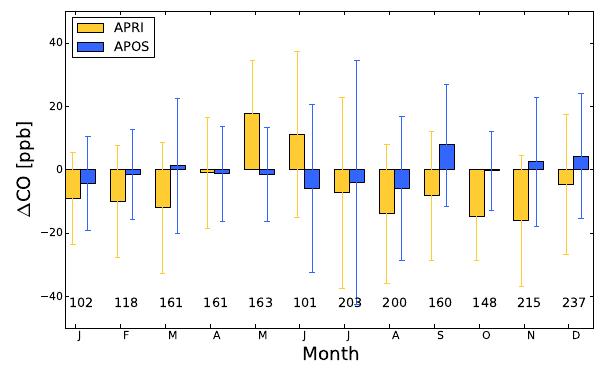
Fig. 4. Monthly mean difference between the TM5 model and NOAA aircraft observations for the prior (yellow) and posterior (blue) simulation. The number of observations per month is also